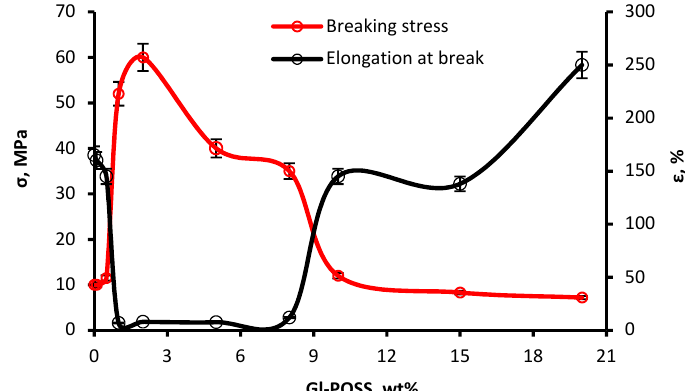
Figure 10. Dependences of the breaking stress ( σ , MPa) and elongation at break ( ε , %) of POI-Gl-POSS on the content of Gl-POSS.